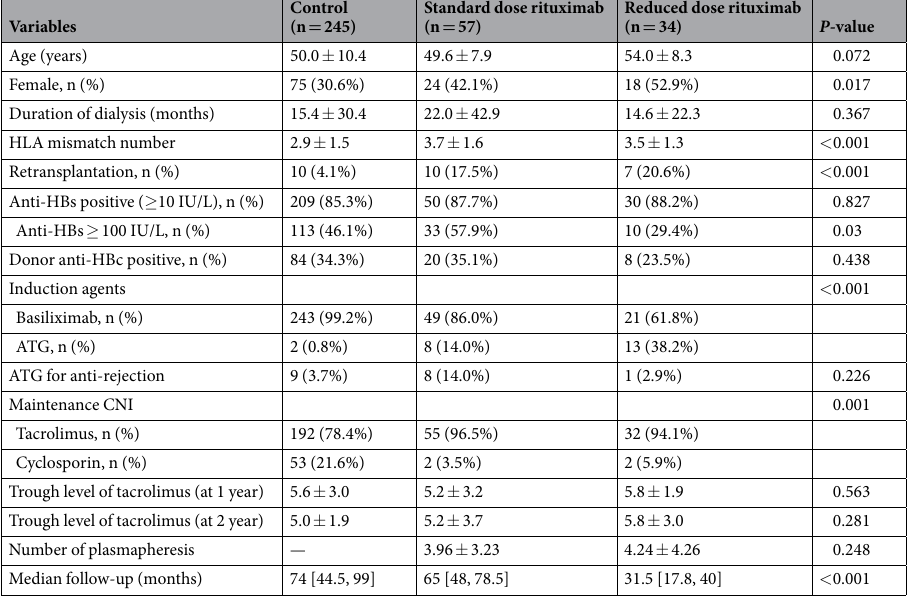
Table 1. Baseline